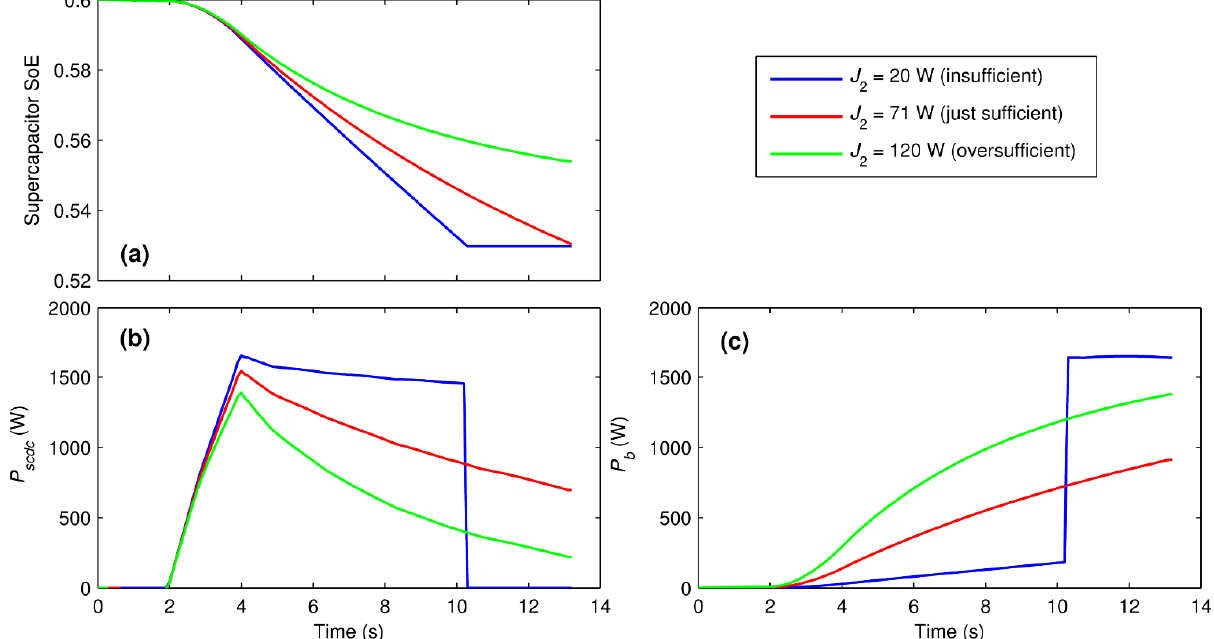
Figure 11. Evaluation of three Pareto solutions with three values of J 2 for the strategy